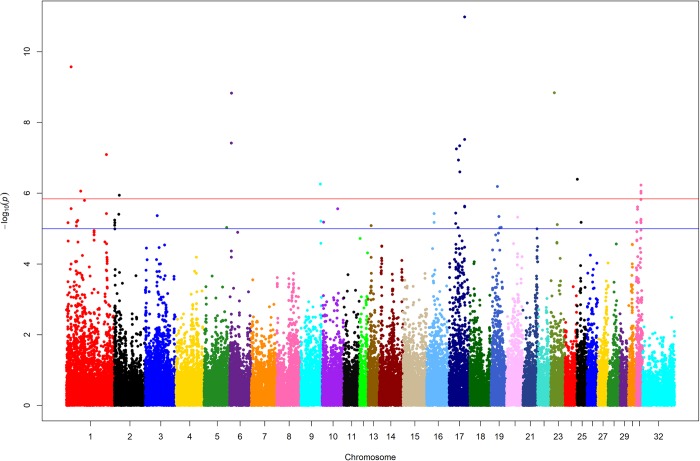
Manhattan plot of results from mixed model analysis using GEMMA.The 31 autosomal and X chromosome (32) are represented in different colors along the x-axis and the–log(p-value) is on the y-axis. Each colored dot represents a SNP. Genome-wide significant hits are on ECA1, 2, 6, 9, 17, 23, 25, and 31. See Table 1 for specific SNPs and p-values. The red horizontal line represents the level of genome-wide significance (p < 1.44 x 10−6-); the blue line represents a cutoff for moderate association (p < 1 x 10−5).